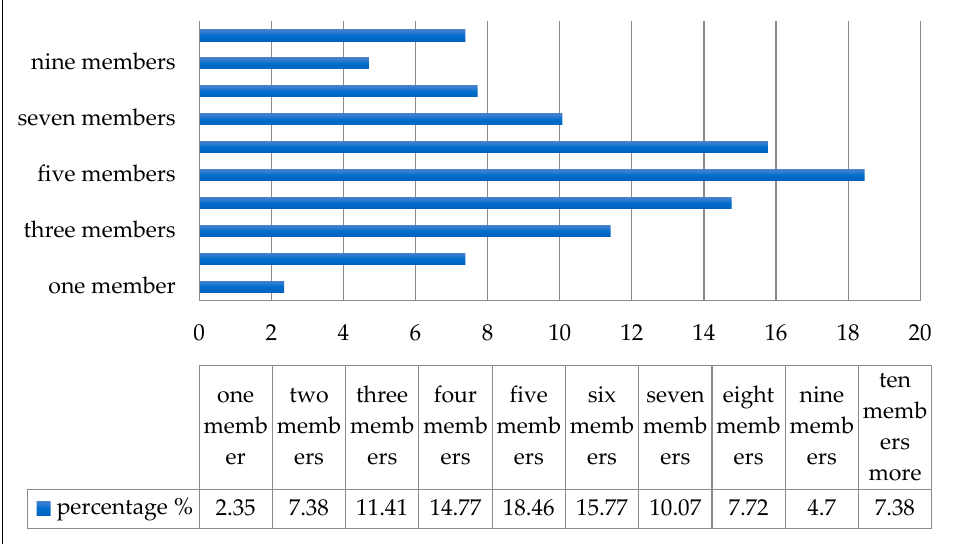
Figure 7. Number of family members in residential units.